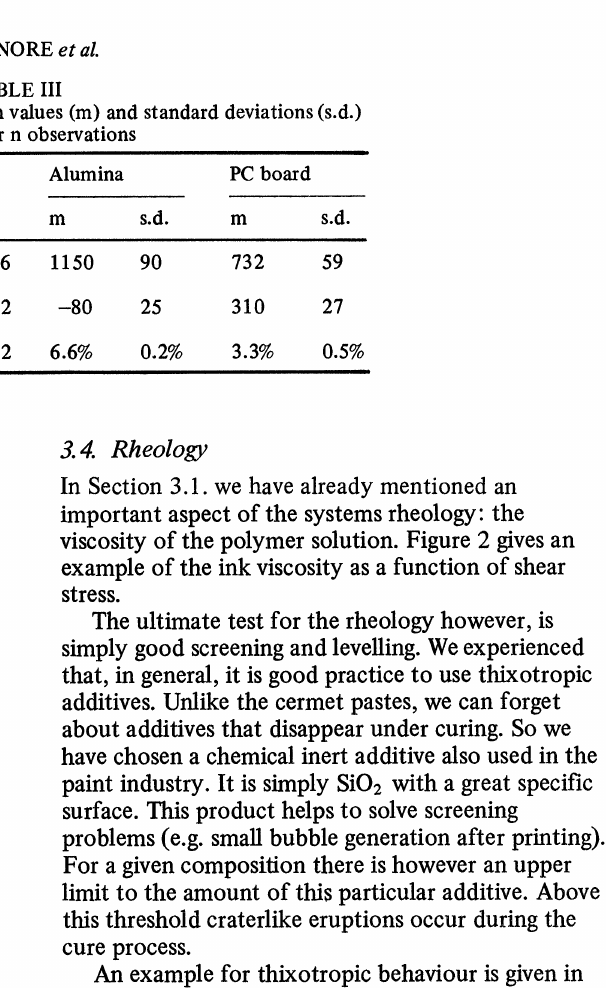
TABLE III Influence of substrate material. Mean values (m) and standard deviations (s.d.) are given for n